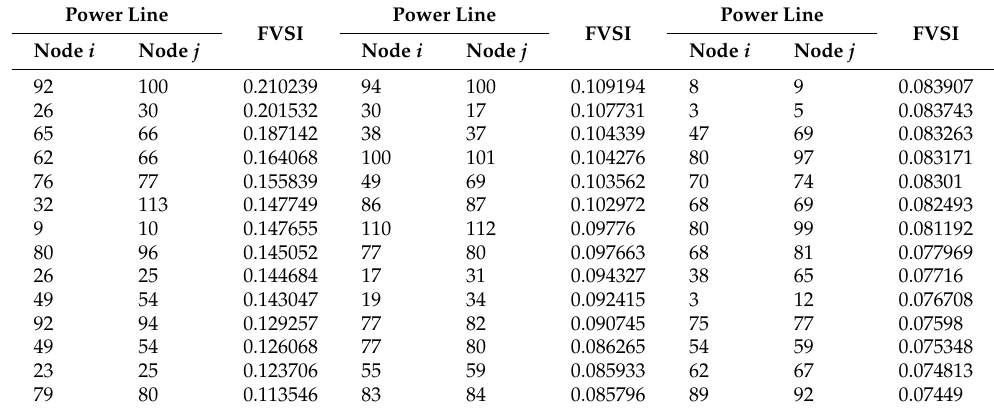
Table 3. FVSI of IEEE 118-bus-bar system before contingency scenarios (42 worst lines).